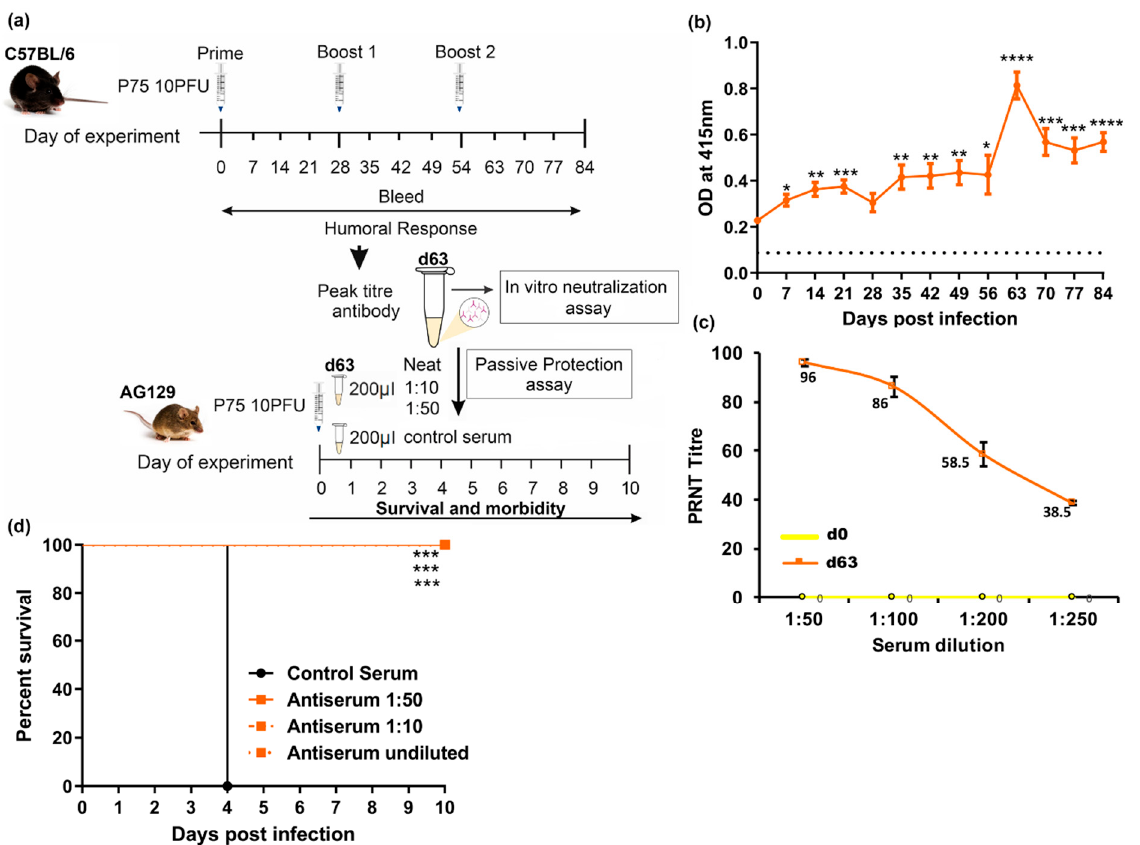
Figure 3. Passive protection assays ( a ) Schematic representation of the experiment design. ( b ) Indirect ELISA for anti-CHIKV antibodies. Two groups of 4- to 6-week-old C57BL/6 mice (n = 6) were immunized thrice with 3-week intervals with 10PFU of CHIKV-attenuated strain virus p75. Serum from individual mice were collected in weekly intervals until 84 days post-infection. Pooled serum at each time point was incubated with recombinant ∆ E2 protein coated in 96-well plates, and bound antibody was detected using anti-mouse IgG-HRP. Orange line indicates the absorbance at 415nm on different days post-immunization. Values represent the mean ± SE of duplicate wells. Dotted lines represent the limit of detection, which is half the value of the average OD reading of day 0 samples. * p < 0.05, ** p < 0.01, *** p < 0.001, **** p < 0.0001 (dpi vs. d0) ( c ) Plaque Reduction Neutralization Test (PRNT) to evaluate CHIKV-neutralizing antibody. Pooled serum from C57/BL6 mice (n = 6) from day 63 post-vaccination was subjected to PRNT assay and compared with day 0 sera. Heat-inactivated serum was 2-fold serially diluted and incubated with 10 2 PFU of p75. The sera–virus mixture was added to the Vero cell monolayer for plaque formation. The number of plaques was counted, and a 90% reduction (PRNT 90 ) was calculated. The data are presented as geometric mean ± SD. ( d ) Passive protection studies in AG129 mice. Two groups of 3- to 4-week-old AG129 mice (n = 6) were infected subcutaneously with 10PFU of p75 variant followed by immediate intraperitoneal administration of 200 μ L of pooled, day-63 post-vaccination serum from immunized animals. Serum was administered either undiluted (orange solid line) or in a 1:10 (orange dotted lines) and 1:50 (orange dashed lines) dilution. Control mice received normal, undiluted mouse serum (black solid line). Mice were monitored daily for survival and morbidity. Survival was compared using Kaplan–Meier survival curves (log rank test). *** p < 0.001 (control serum vs. antiserum undiluted/1:10/1:50 dilutions). Antiserum-treated groups (orange lines) are merged, and the percent survival is 100% for 3 dilutions.